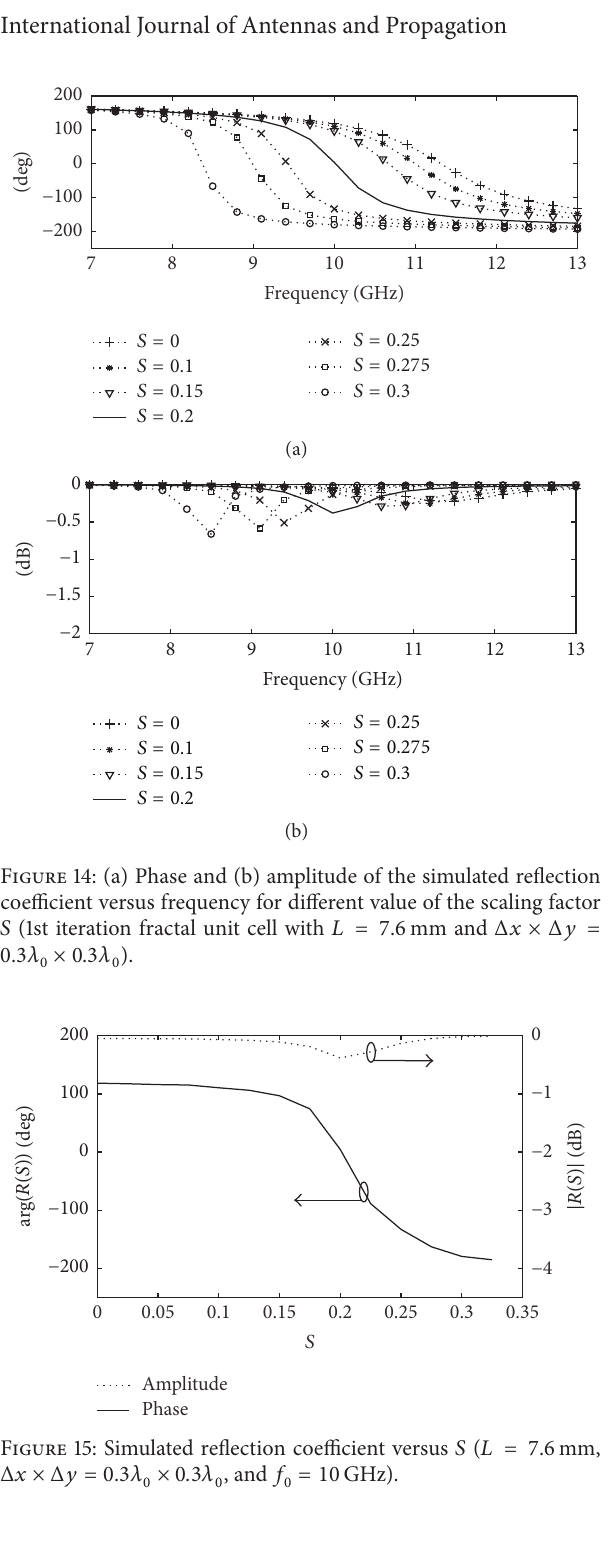
× 0.3𝜆 𝑓 = 10 GHz). 0 0 , and 0